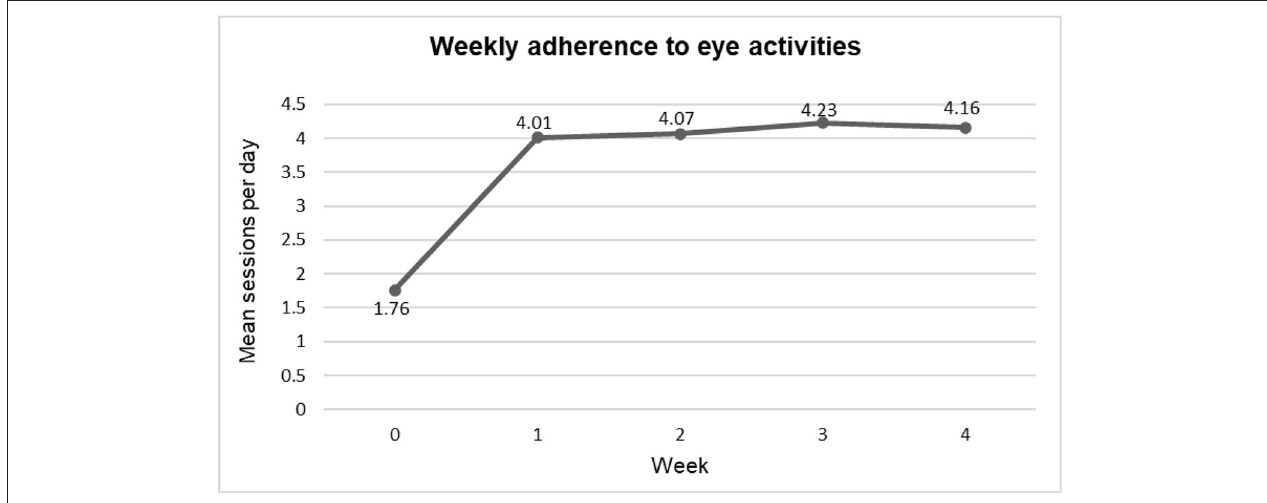
FIGURE 3 | Weekly mean adherence to regular eye activities as per daily diary record.